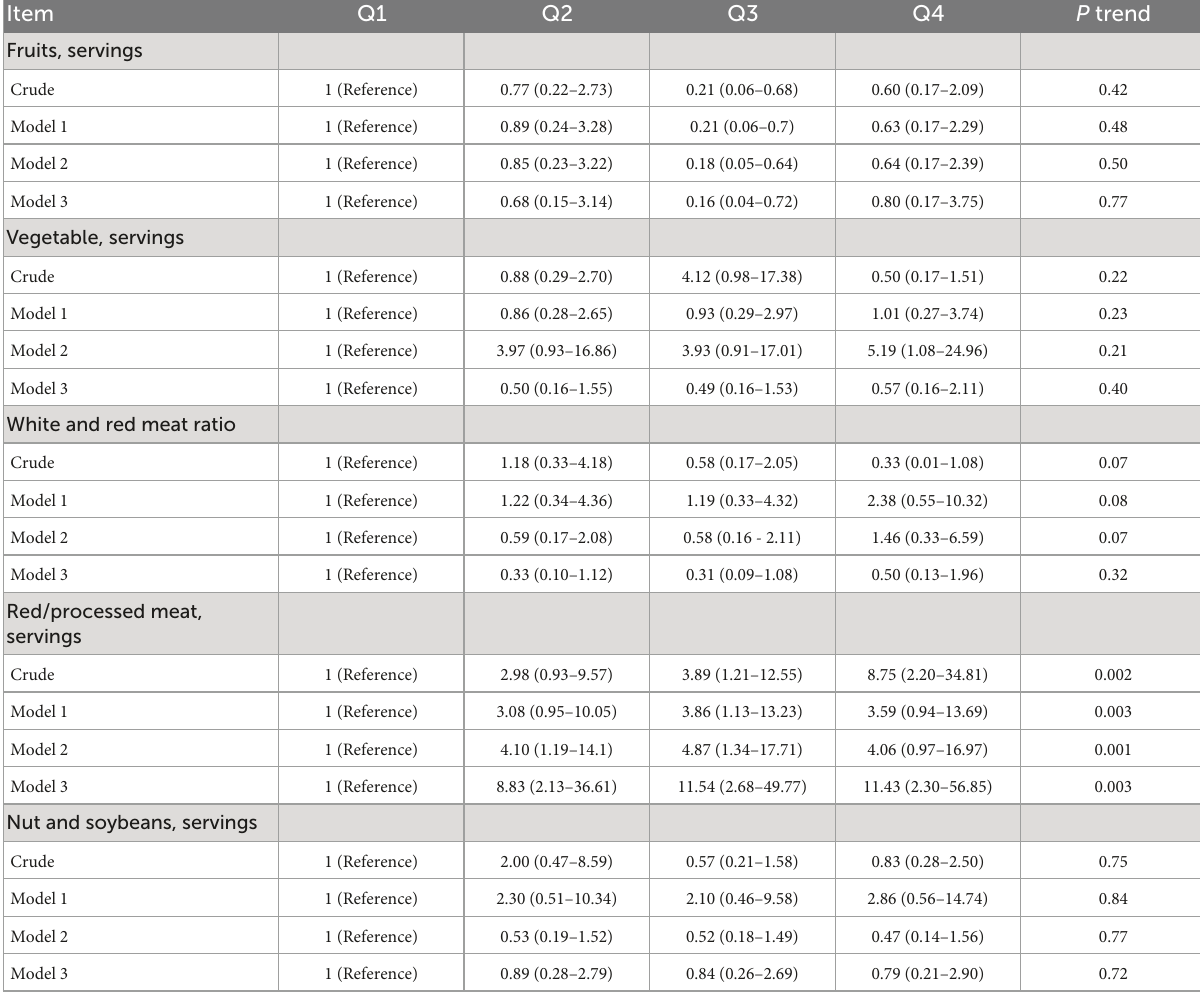
TABLE 5 Risk of incident chronic kidney disease by dietary indices in the renal transplant recipients. Item Q1 Q2 Q3 Q4 P